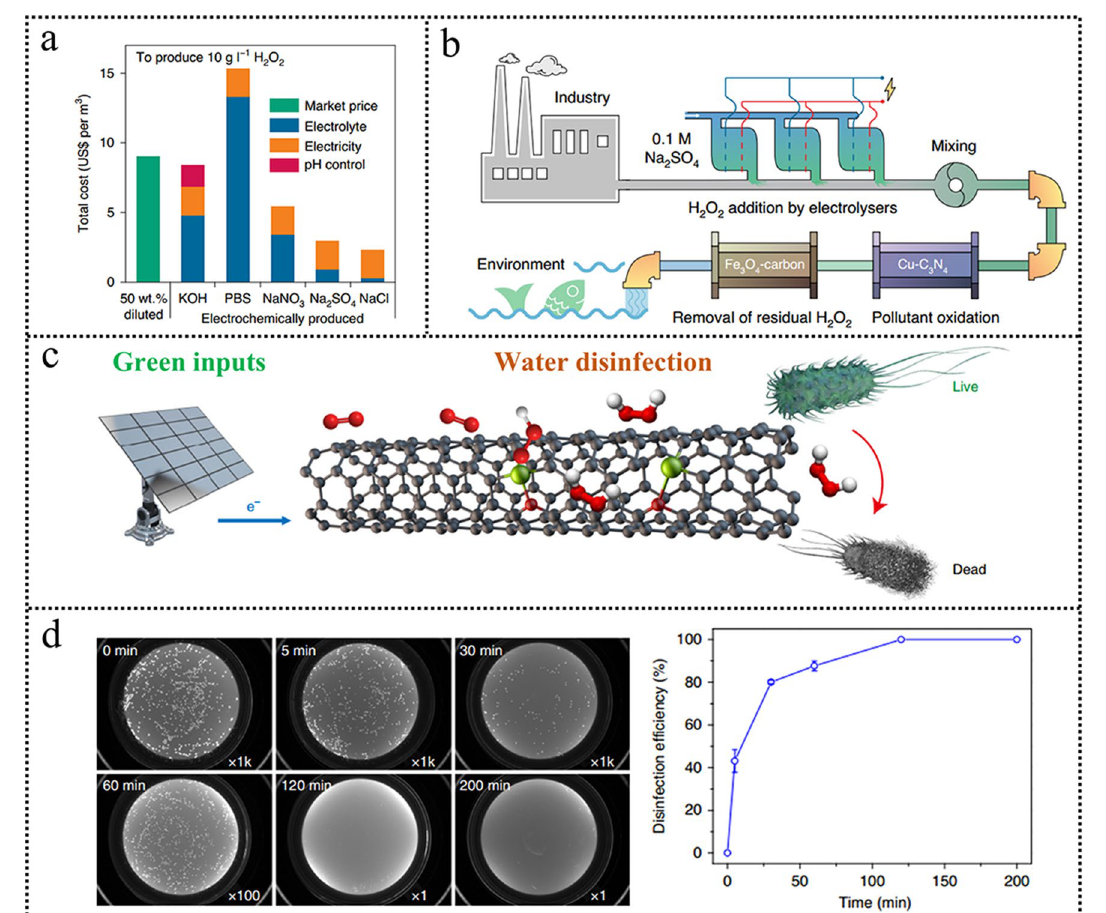
Fig. 11 a Cost estimate for producing 10 g L −1 (1 wt%) H 2 O 2 solution using different electrolytes (0.1 M). b Schematic drawing of the wastewa- ter treatment system. Reproduced with permission [111]. Copyright 2020, Springer Nature. c Schematic of electrochemical synthesis of H 2 O 2 for water disinfection, with green inputs such as sunlight, air, and water. d Water disinfection efficiency. Reproduced with permission [21]. Copy- right 2019, Springer Nature. (Color figure